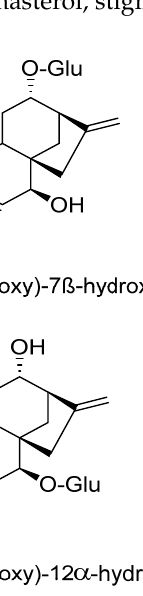
Figure 6. Novel isolated compounds of C. pepo seeds.